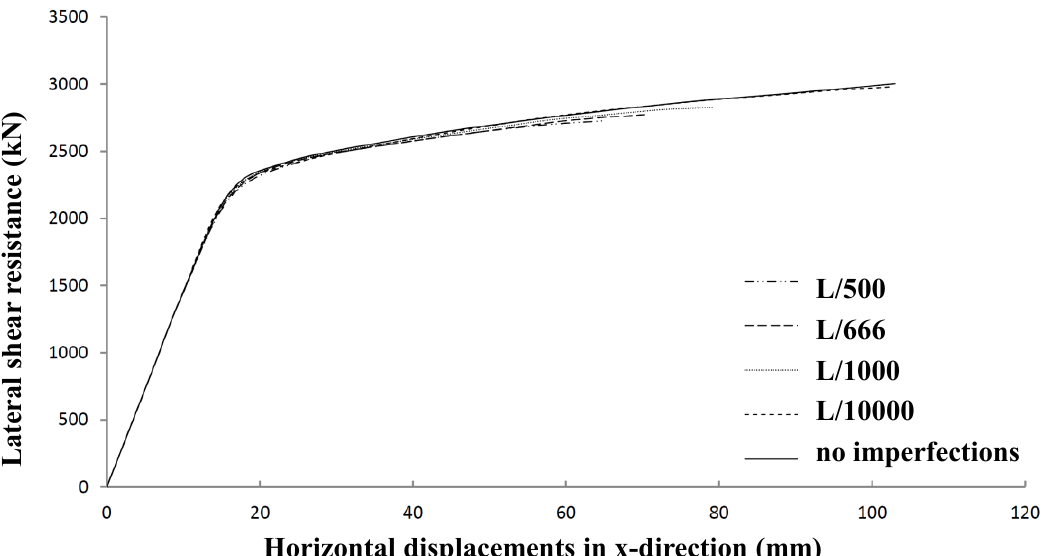
Figure 19. Influence of geometrical imperfections on lateral shear panel resistance.